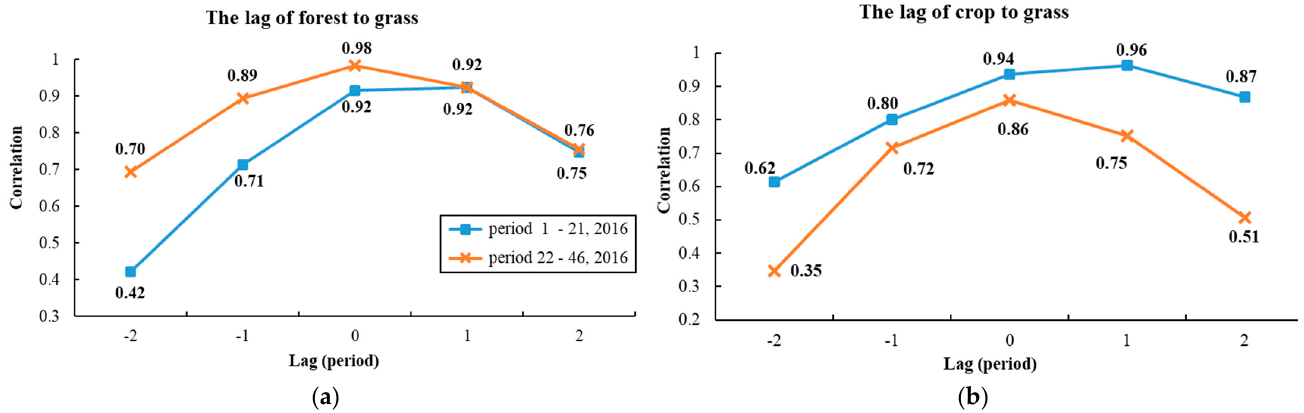
Figure 7. Comparison of time-lag effect among different vegetation types. ( a ) The data of forest and grass was selected from station 1, and ( b ) the data of agriculture and grass was selected from station 2.